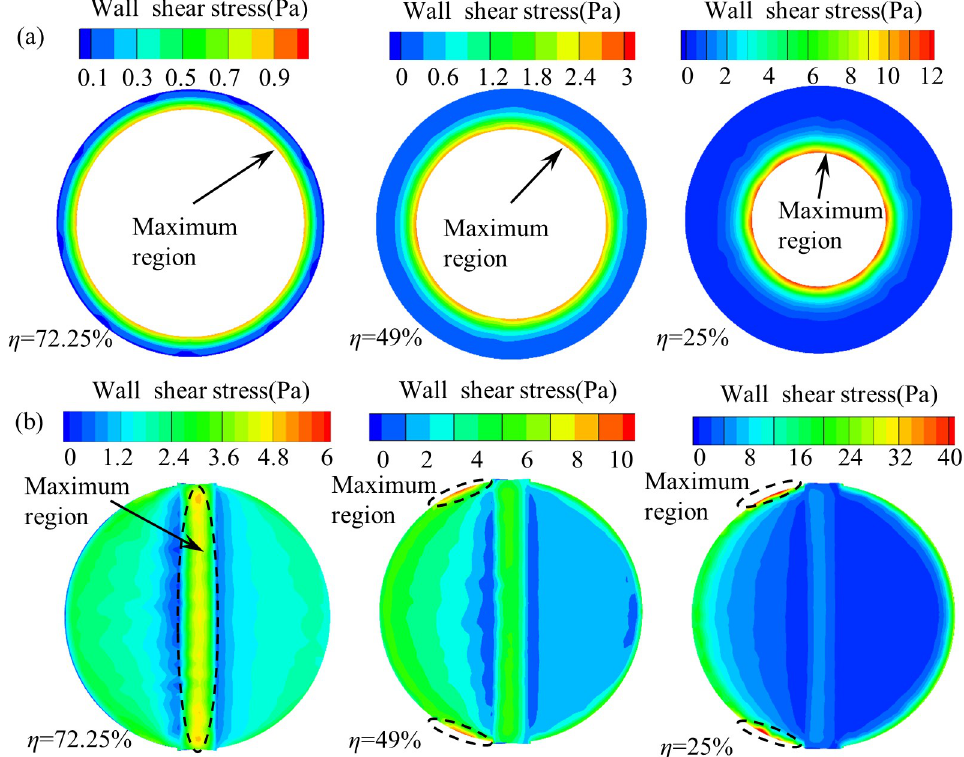
Fig 10. Wall shear stress distribution of the two valves at different valve openings. (a) Air-ring flow regulating valve. (b) Center butterfly valve.